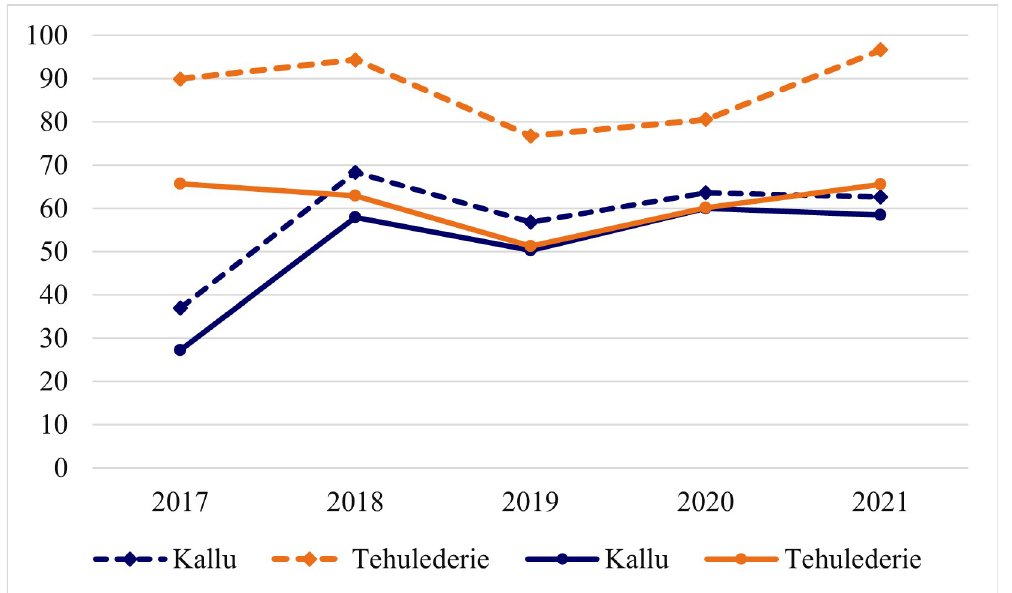
Fig 1. Trends in community-based health insurance enrollment in two case study districts of northeast Ethiopia between 2017 to 2021. Note: Solid lines represent coverage ratios while broken lines represent renewal ratios, both in